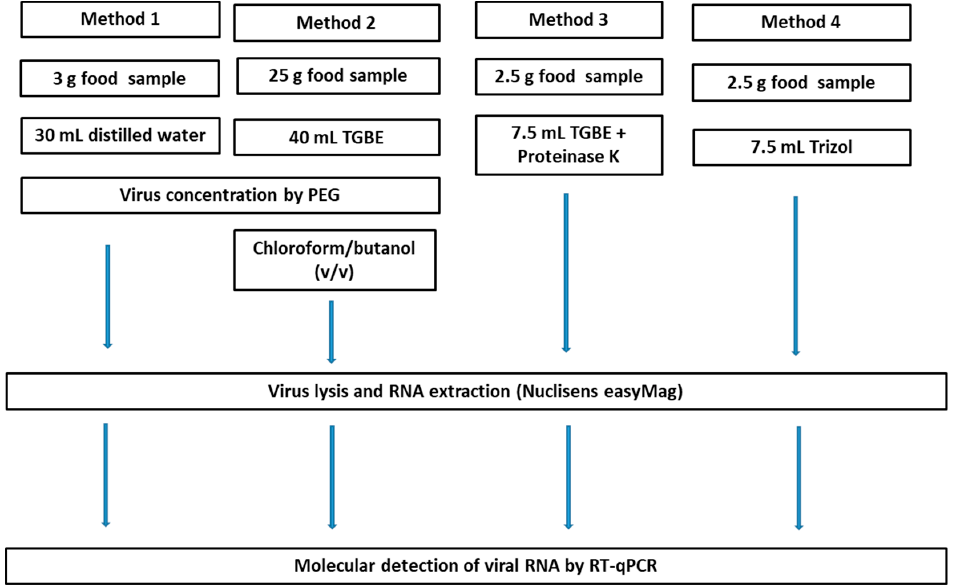
Figure 1. Flowchart of method 1 to method 4 evaluated for the detection of MNV-1 in raw salmon and smoked herring.